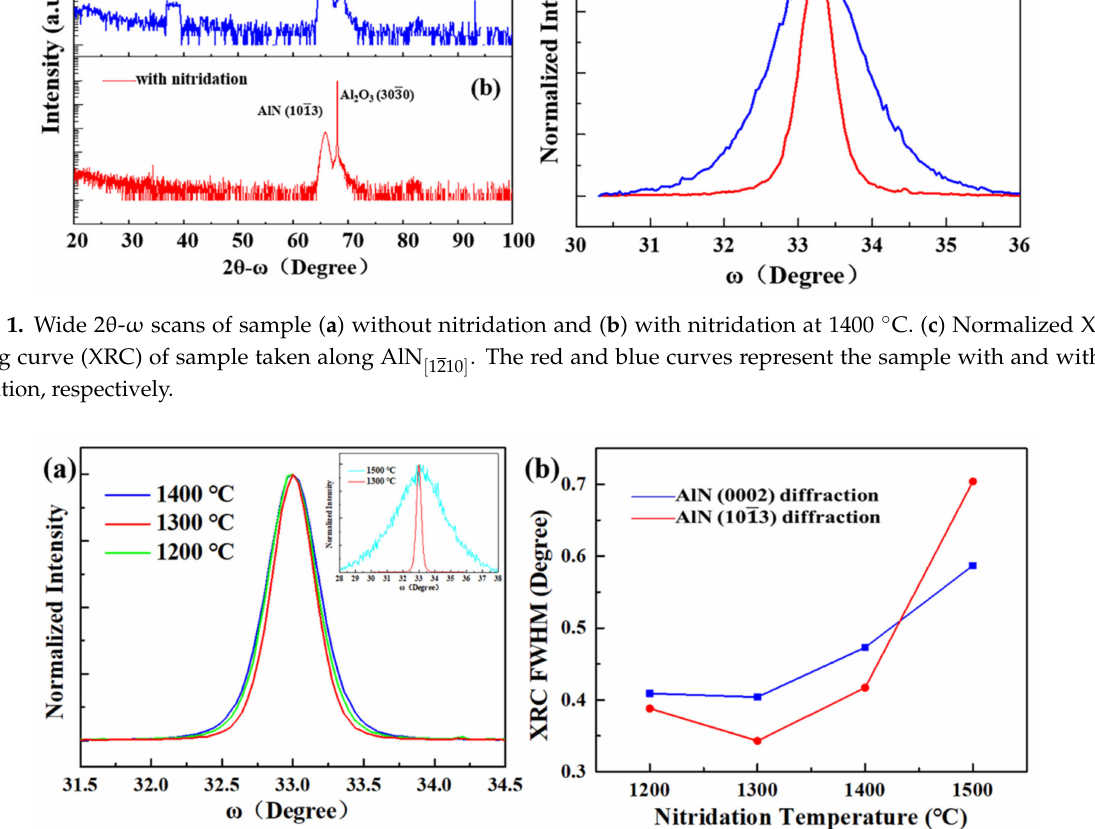
Figure 2. ( a ) Normalized XRC of samples with different nitridation temperatures. The green, red, blue and cyan curves are samples nitrided at 1200, 1300, 1400 and 1500 ◦ C, respectively. ( b ) FWHM values as a function of nitridation temperature. The red and blue curves are (1013) and (0002) diffractions,